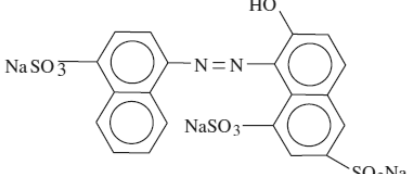
Figure 1. Chemical structure of